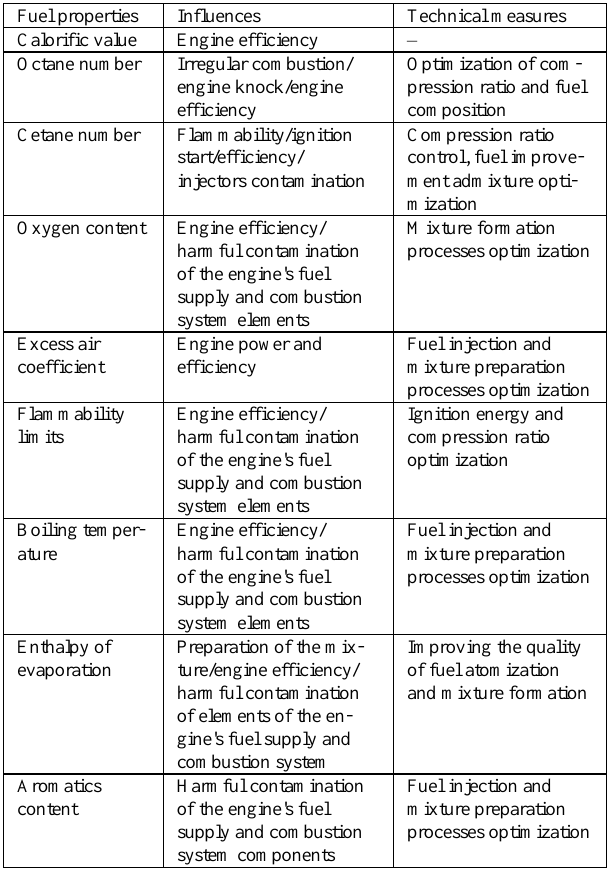
Table 1. List of fuel properties that have significance with respect to the engine design and operation